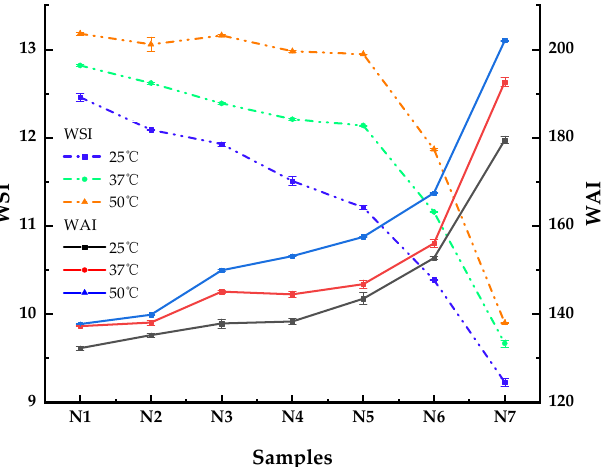
Figure 1. The WAI and WSI of tartary buckwheat noodle flour. N1–N7 respectively represent noodles with 0%, 10%, 20%, 30%, 40%, 50% and 60% HTBF